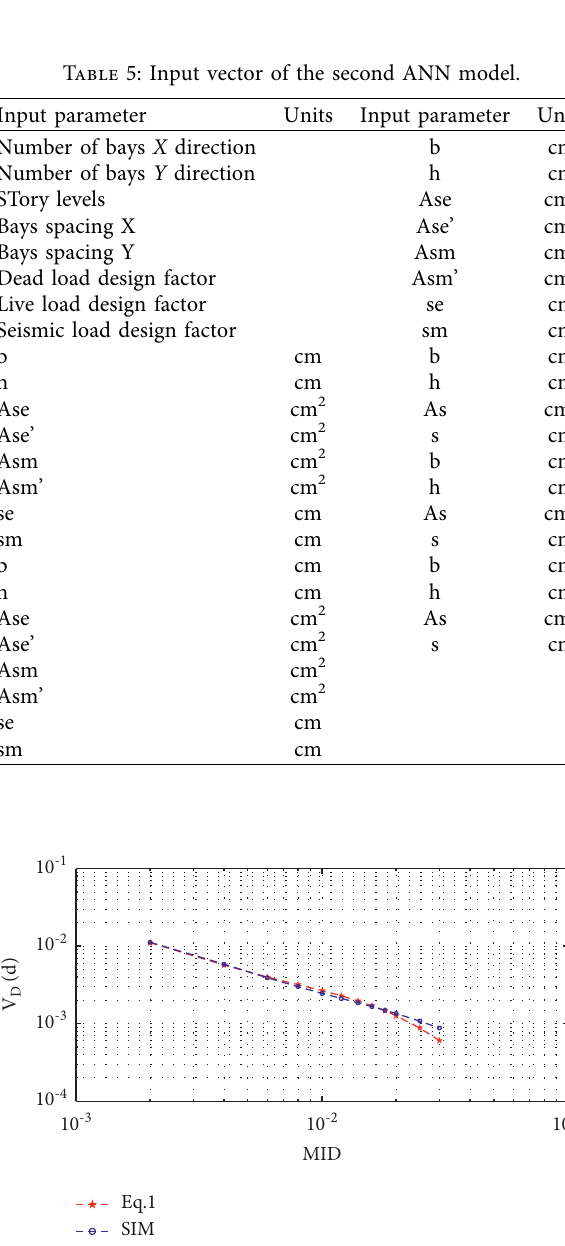
Figure 13: 12-story building seismic demand hazard curve results comparison using equation (1) and the ANN